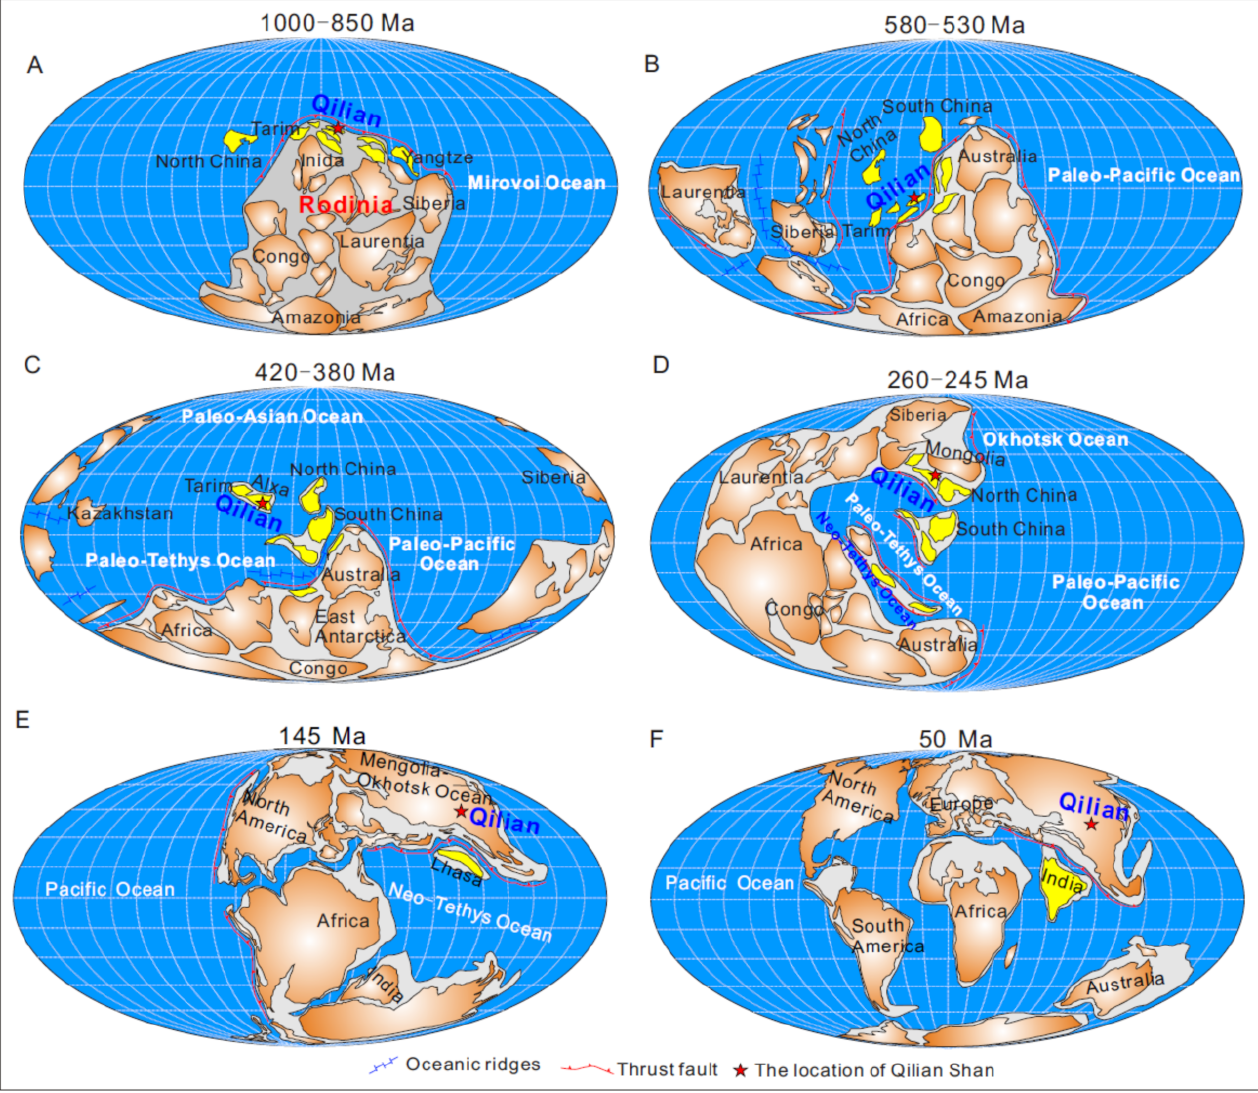
Figure 3. Meso-Neoproterozoic and Cenozoic paleogeographic maps (Modifed from [73,78]). ( A ) The Rodinia supercontinent at its maximum expansion (1000–850 Ma); ( B ) late Neoproterozoic-Early Paleozoic spreading of the Qilian Ocean; ( C ) collision of the Qilian and Alxa blocks and closure of the Qilian Ocean; ( D ) progressive closure of the Paleo-Tethys Ocean and exhumation of the Qilian Shan; ( E ) the collision of the Lhasa plate with Eurasia caused the exhumation of Qilian Shan during the Early Cretaceous; ( F ) the Indian plate collided with Eurasia in the early Cenozoic and caused the exhumation of Qilian Shan. The red star marks the position of the Qilian